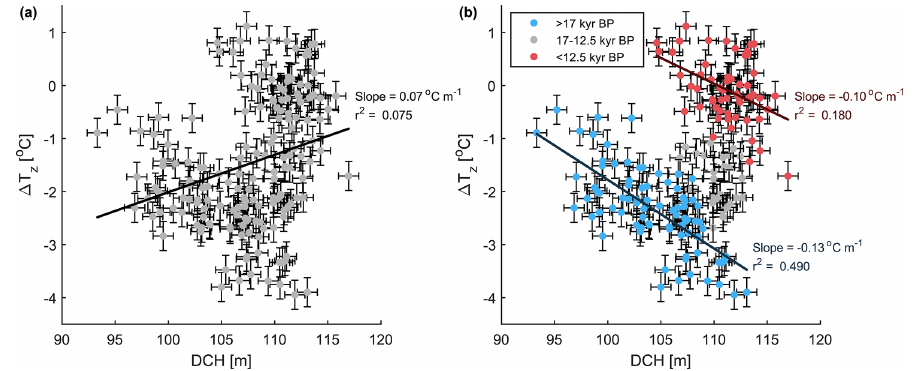
Figure 2. Firn temperature difference plotted against the diffusive column height. Error bars represent 1 pooled standard deviation of replicate samples. In panel (a) , the data are plotted in grey along with a regression to the entire dataset. In panel (b) , data older than 17kyrBP are plotted in blue, data younger than 12.5kyrBP are plotted in red, and a least squares linear fit to each subset is shown. The slope and squared correlation coefficient, r 2 , of each fit is also